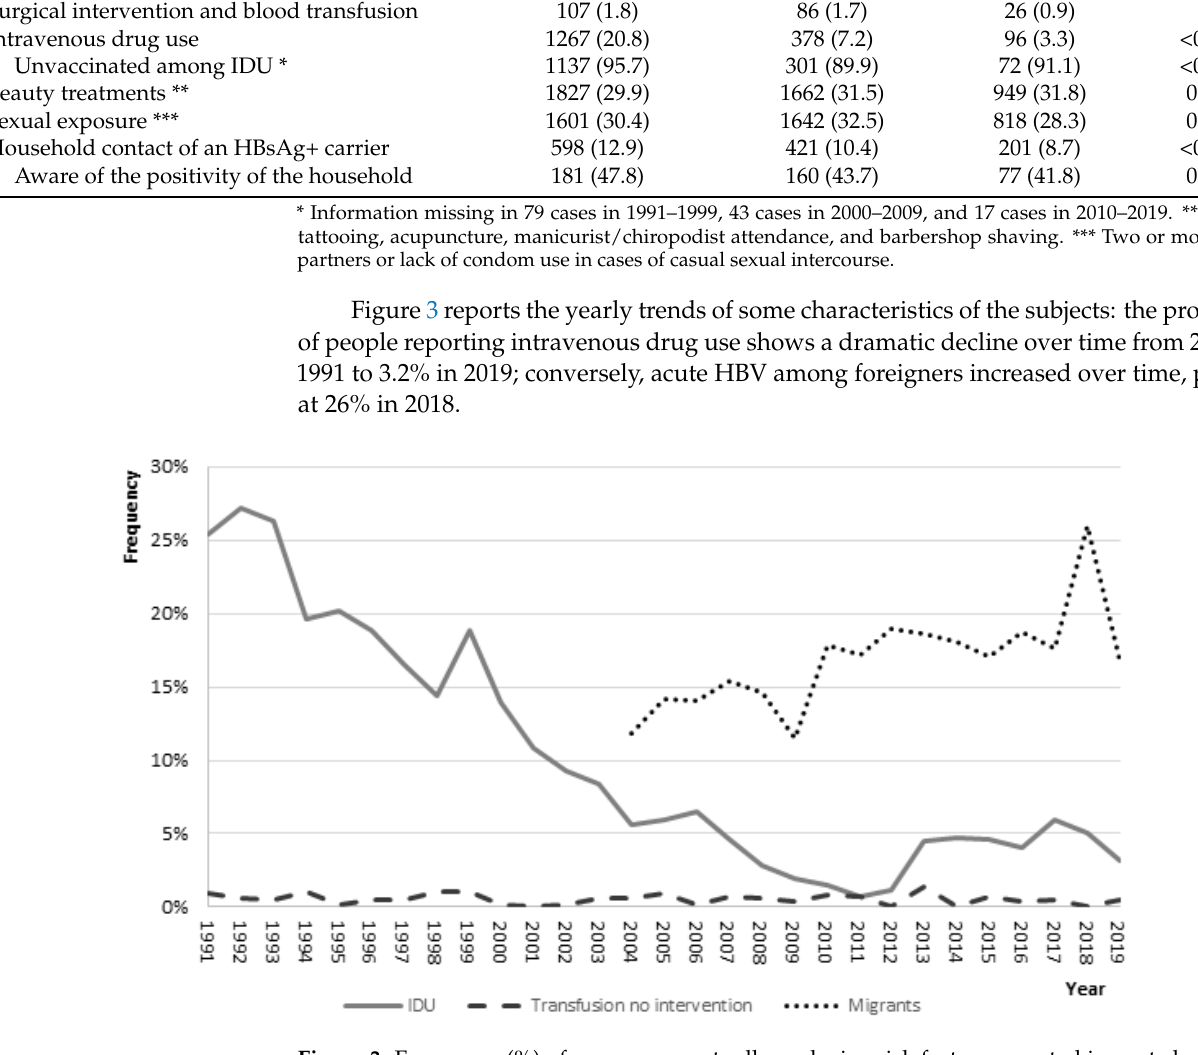
Figure 3. Frequency (%) of some non-mutually exclusive risk factors reported in acute hepatitis B cases by year. SEIEVA 1991–2019.